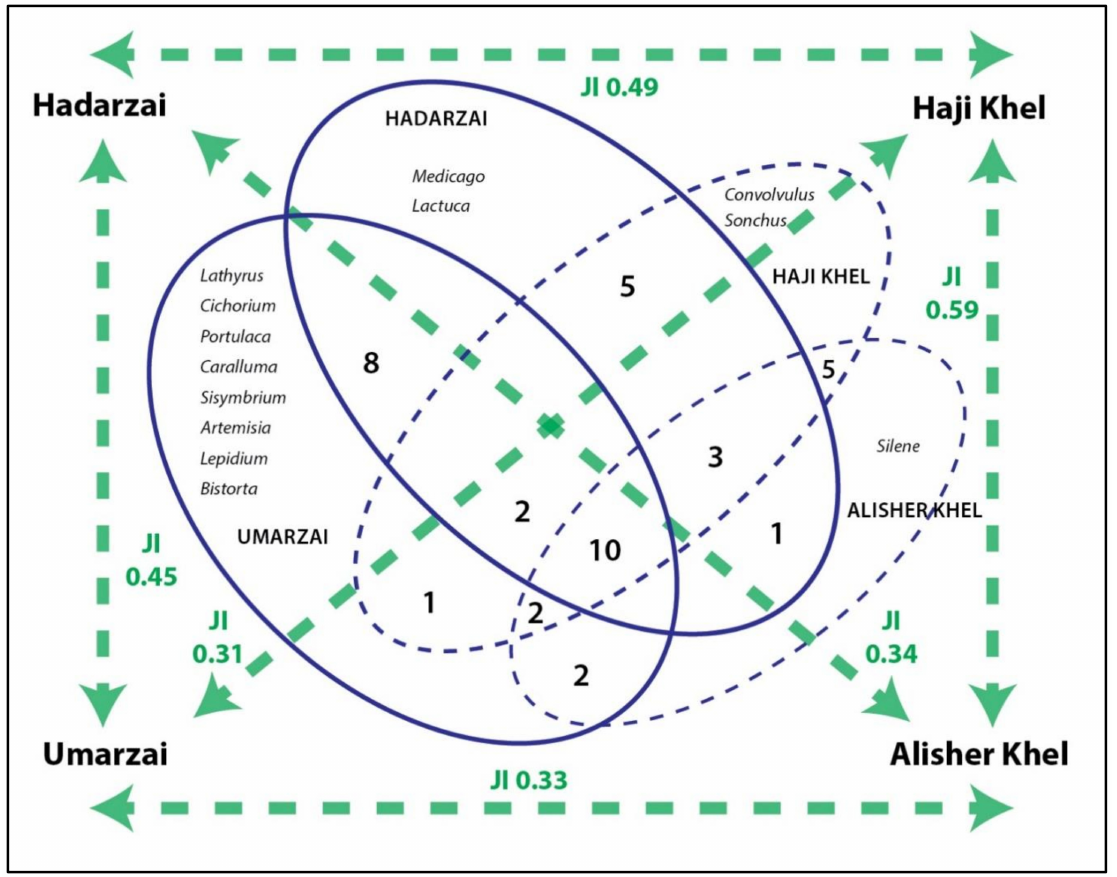
Figure 10. Venn diagram showing the overlap of wild vegetables (genera) use among the four considered groups, as well as the Jaccard similarity